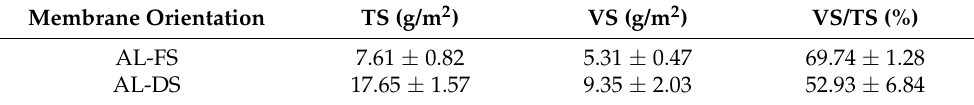
Table 4. Analyses of the foulants on the membrane surfaces at both membrane orientations a .